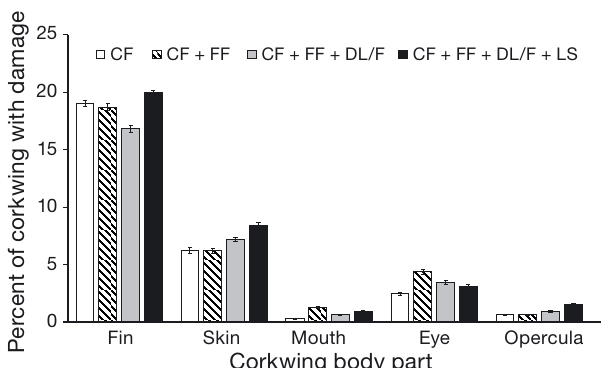
Fig. 7. Percent (mean ± SE) of corkwing wrasse with fin, jaw, skin, eye and opercula damage for each anti-lice strategy. See Fig. 1 for abbreviations